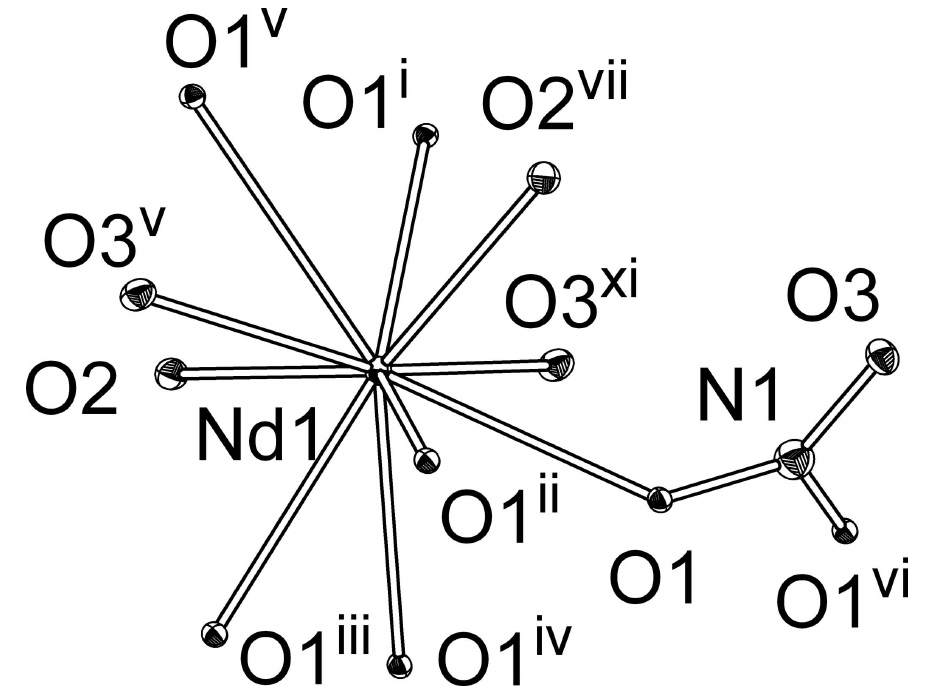
Figure 1 A fragment of the structure of (I), showing the Nd coordination sphere and displacement ellipsoids at the 50% probability level. [Symmetry codes: (i) -1/2 + x , y , 1.5 - z ; (ii) x , 0.5 - y , z ; (iii) 1 - x , 1/2 + y , 2 - z ; (iv) 1 - x , - y , 2 - z ; (v) -1/2 + x , 0.5 - y , 1.5 - z ; (vi) x , -0.5 - y , z ; (vii) 1/2 + x , 0.5 - y , 1.5 - z